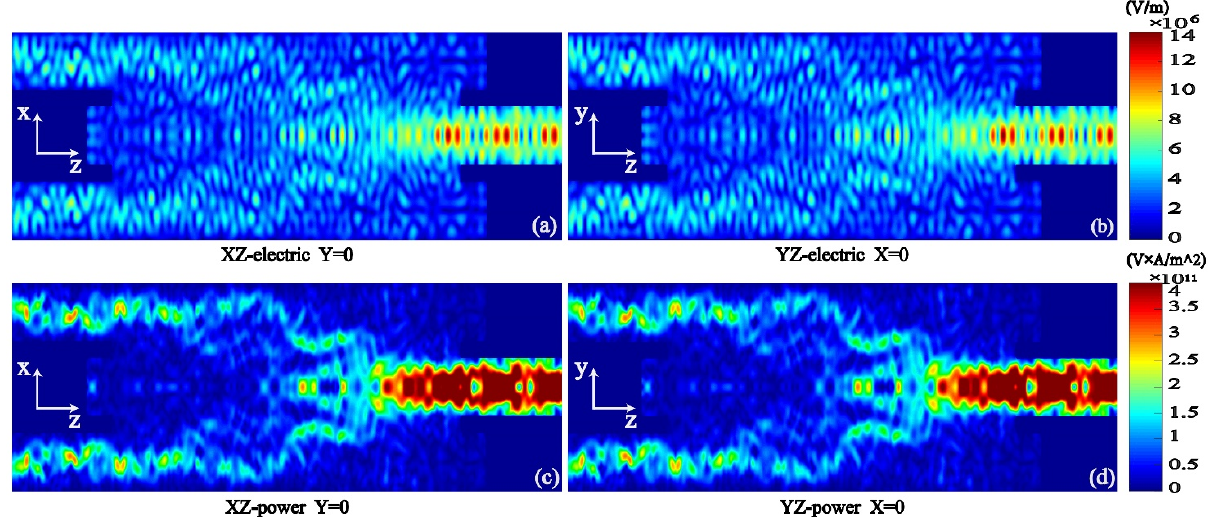
Figure 8. ( a ) Electric field distribution on XZ cross section, ( b ) electric field distribution on YZ cross section, ( c ) power distribution on XZ cross section, ( d ) power distribution on XZ cross section.